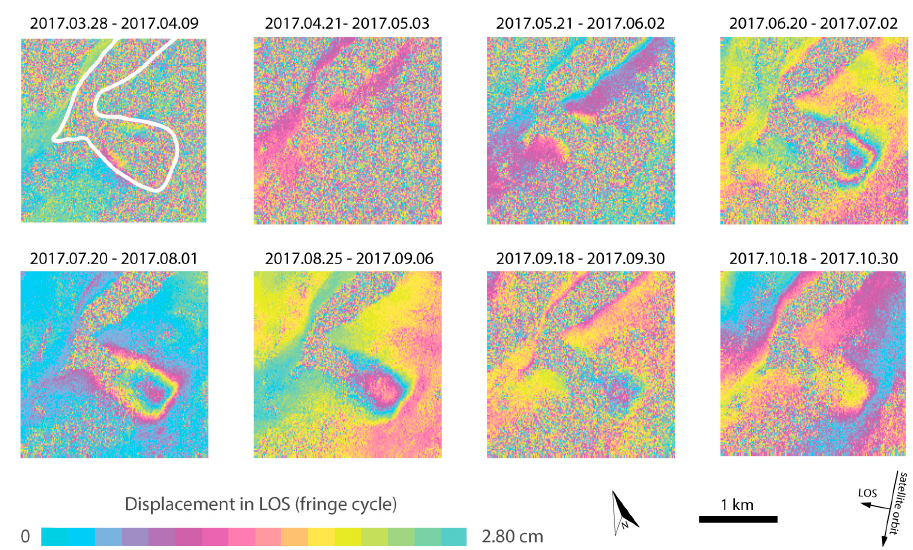
Figure 3. Selection of the Sentinel-1 (track 66, descending orbit) differential interferograms with 12-days temporal separation over the area of Moosfluh rock slope instability for the period March–October 2017. Time of acquisition for each SAR image pair analyzed is provided in the format YYYY.MM.DD. White the boundary in the upper left interferogram delineates the approximate area of the Aletsch glacier and Moosfluh slope instability (cf. Figure 1). Differential interferograms were generated by using a high resolution DEM (SwissALTI3D, 2 m GSD) and filtered [40] to increase signal-to-noise ratio. See also the Supplementary information for the full set of differential interferograms computed.